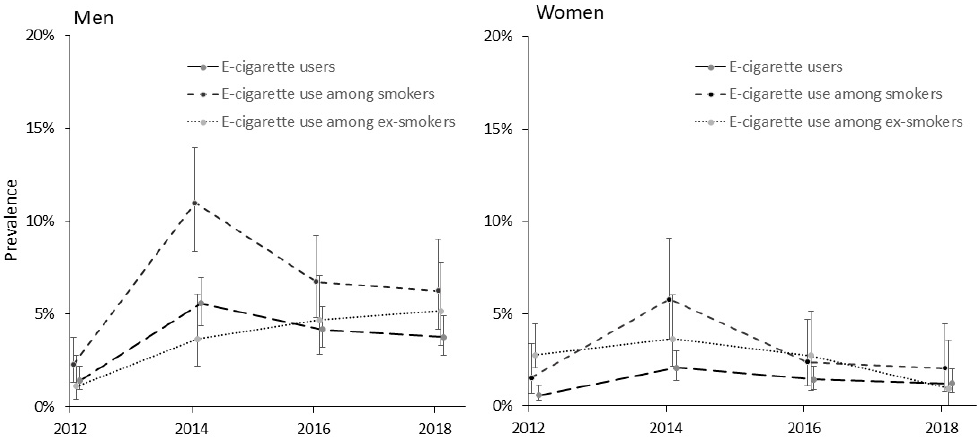
Figure 1. Prevalence of e-cigarette use in Estonia, 2012–2018.